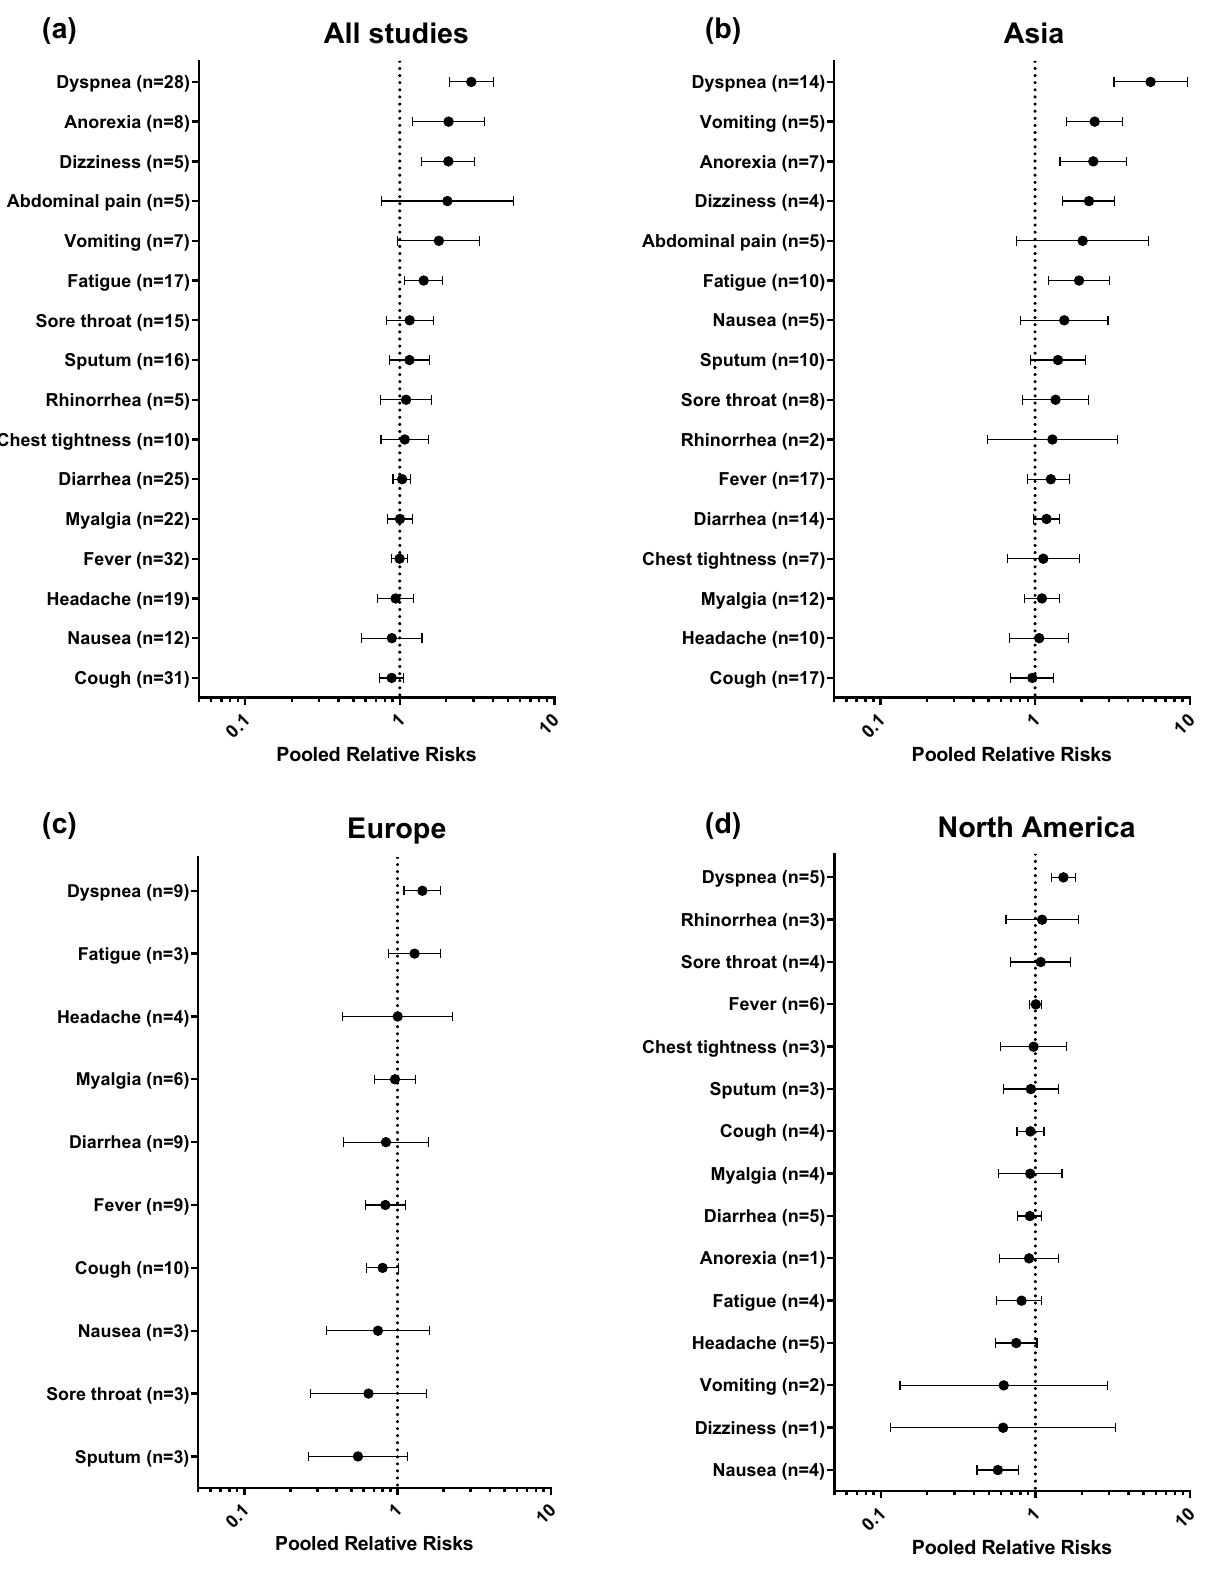
Figure2. Impacts of patient symptoms on the critical outcome of COVID-19. The numbers in parenthesis represent the number of studies included in the pooled analysis. ( a ) Pooled analysis of all included studies. ( b )– ( d ) Pooled analyses of studies performed in Asia, Europe, and North America,